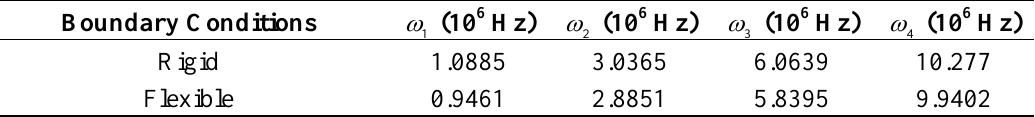
Table 4. The first four natural frequencies of the beam solved by FEM.